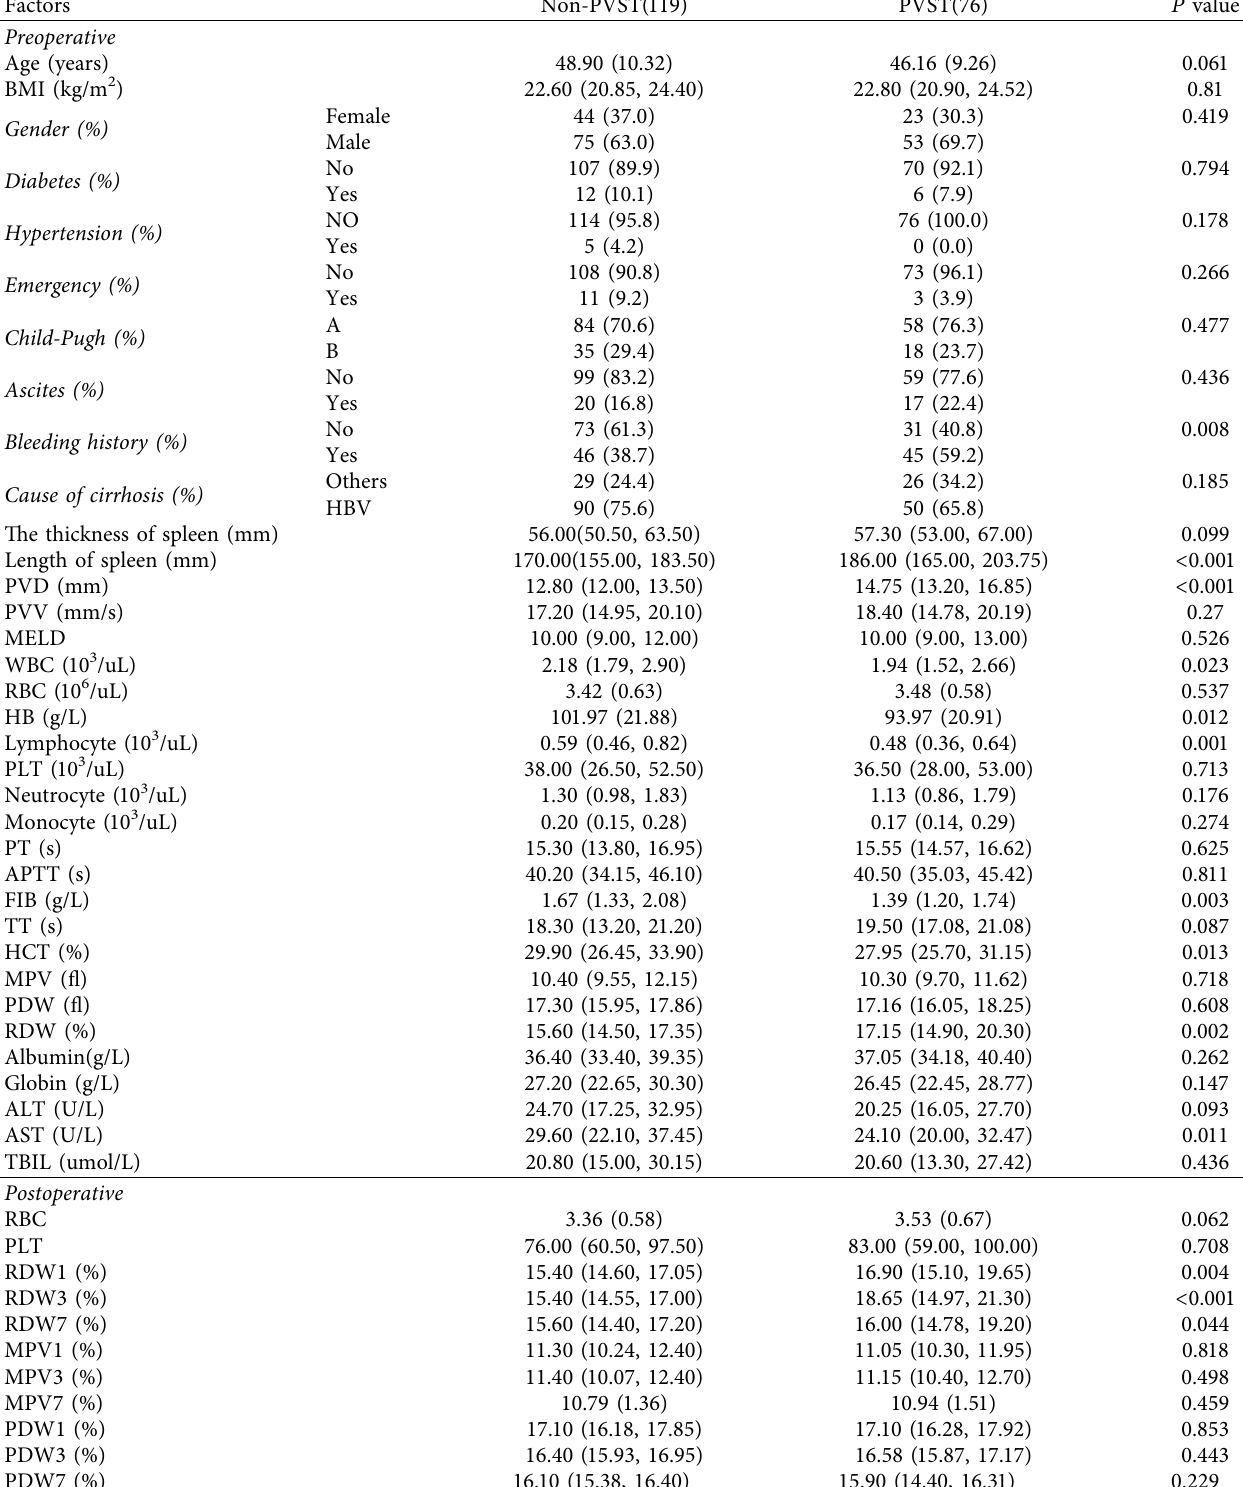
Table 1: Characteristics of patients in the non-PVST and PVST groups.